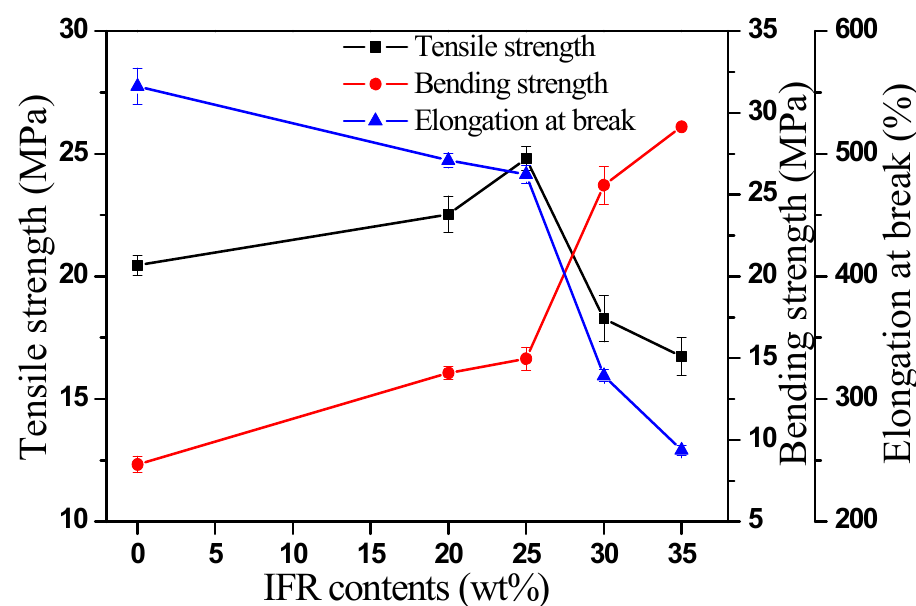
Figure 10. The tensile strength, bending strength and elongation at break of EPDM/PP composites with different content of reactive flame retardant.